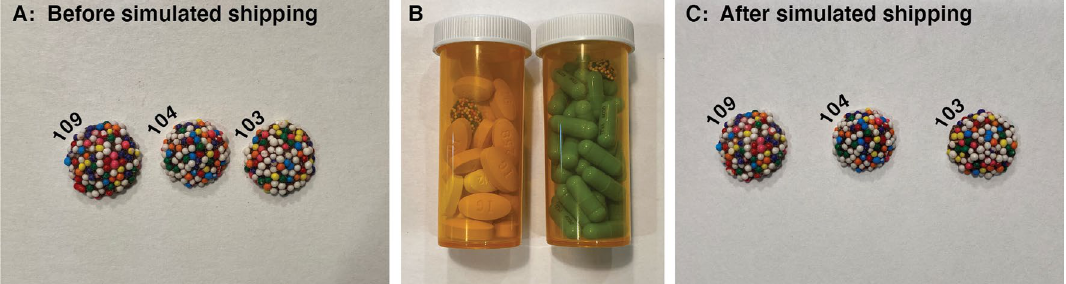
Figure 5. To replicate the experience of a consumer interacting with CandyCoded medications, three CandyCodes from the test library of 120 chocolate-based CandyCodes shown in Fig. 3 were selected at random and photographed again (A) . These “suspect” CandyCode photos were converted to sets of strings using the process described in Fig. 4 and compared with the library of known-good CandyCodes. The matching CandyCodes were found in the library, proving that these “suspect” CandyCodes are indeed authentic (details in the text in "Searching for suspect CandyCodes in the known-good database" Section). To test whether shipping- induced damage might adversely affect CandyCoded medicines, the same three CandyCodes were added to medicine bottles containing commercial pharmaceutical tablets and capsules (B) , and the CandyCodes were then subjected to extreme physical abuse by tumbling the bottles in a modified rock tumbler nonstop for one week. The CandyCodes were then removed from the bottles and photographed again (C) , and the